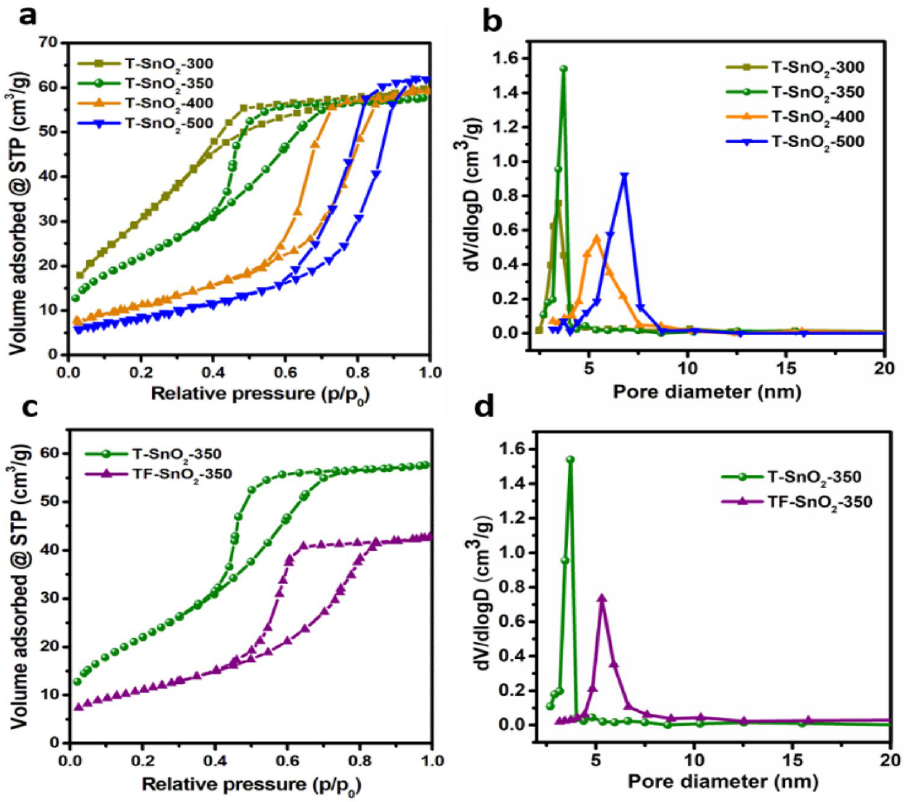
Figure 1. ( a , c ) Nitrogen sorption isotherm and ( b , d ) pore size distribution of SnO 2 catalysts. (Reproduced from reference 3 ).